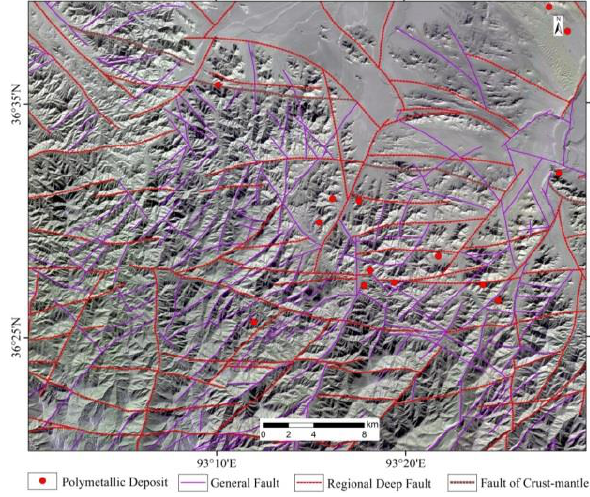
Figure 5. Linear construct information.